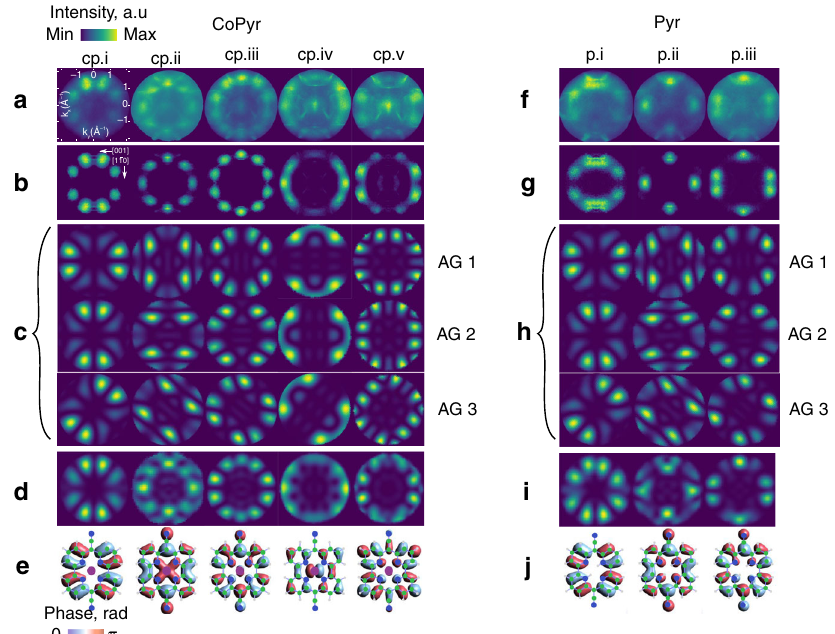
Fig. 4 Angle-resolved photoelectron spectroscopy (ARPES) data and simulated photoelectron momentum maps (PMMs). a – e Co-pyrphyrin (CoPyr). f – j Pyrphyrin (Pyr). a , f Raw ARPES data on Ag(110) substrate. b , g PMMs after background subtraction and normalisation. c , h Simulated PMMs for indicated adsorption geometries (AG) based on gas-phase DFT data. d , i Incoherent sum of PMMs: CoPyr (AGs 2, 3, 3 ′ weighted 1.5:1:1), Pyr (AGs